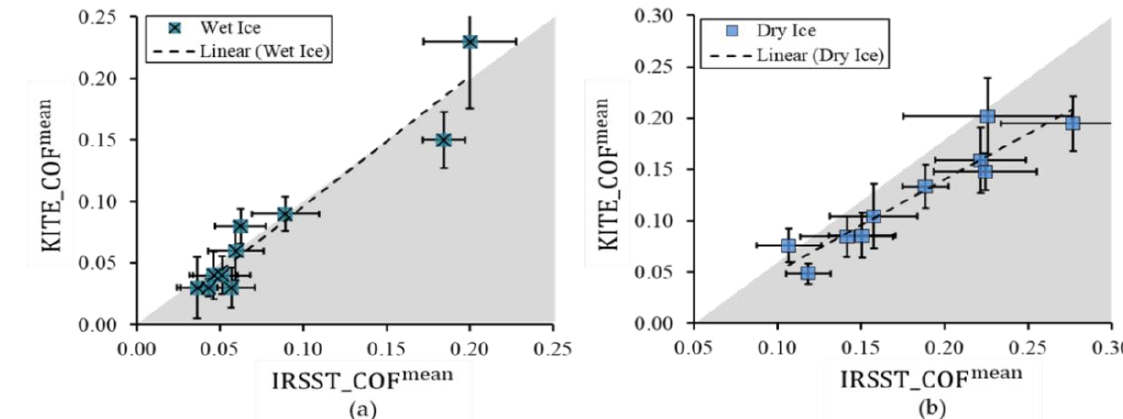
Figure 8. A comparison between mean COFs obtained from SATRA devices in KITE and IRSST for ( a ) wet ice and ( b ) dry ice surfaces. The gray area includes the points where IRSST_COF mean ≥ KITE_COF mean .